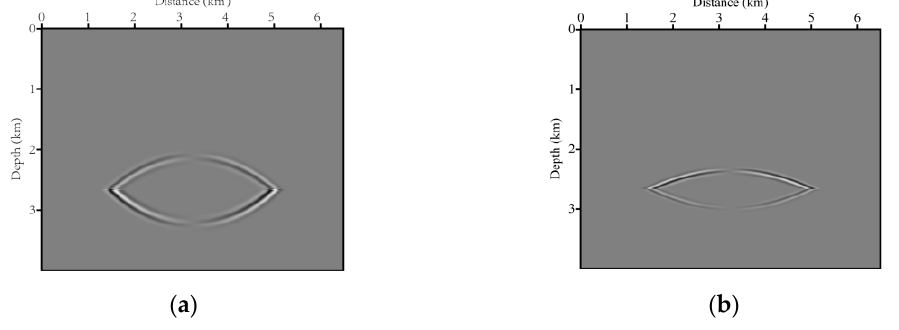
Figure 3. 𝑥 -component of the stained wavefield: ( a ) Pure P-wave; ( b ) Pure S-wave. Furthermore, we utilize a contrastive approach to illustrate the adaptability of the ERTM for different equations. We evenly deploy 10 shots and 650 receivers on the surface of the layered velocity model. The total length of seismic records is 3 s, with a step time of 1ms. Figure 4 shows the multi-shot stacked images based on VDWE. Moreover, we implement the ERTM using the SVDWE, the PP and PS images are sketched in Figure 5. The settings of the stained target are the same as